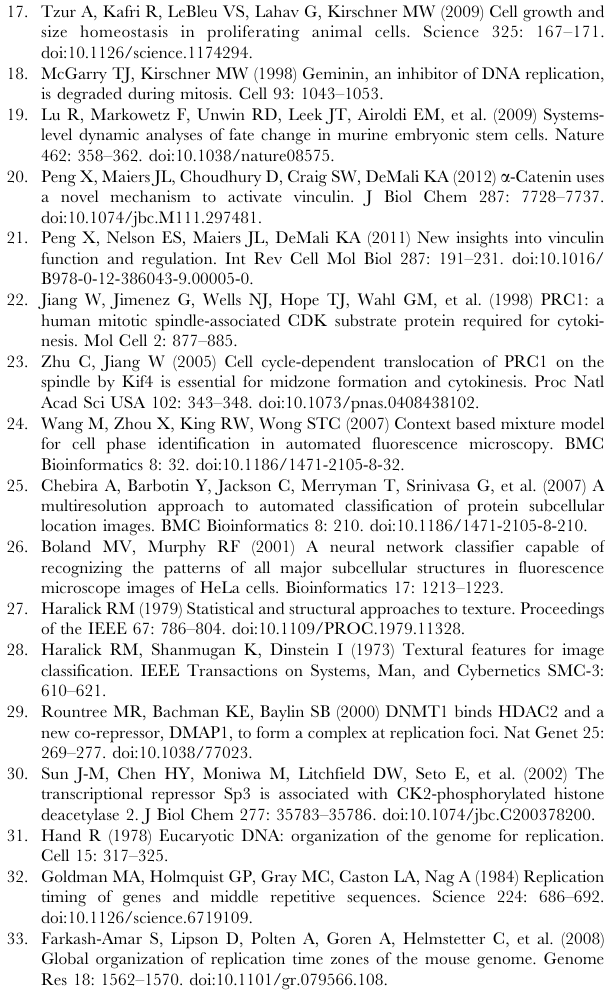
threshold distance of 0.3 was determined to exclude 95% of the experimental variation. (TIF) Figure 10 Normalization of partial tracks of single cells. This example illustrates how partial tracks of a single cell that divided 8 hours after the beginning of the movie to 2 daughter cells were used. The partial tracks were normalized to the average cell cycle (21 hours) and overlaid on the cell-cycle profile accordingly. (TIF) Table S1 The Supplementary table S1 includes the full dataset of protein profiles and scores. (XLSX) Material S1 The online Supplementary material includes additional information about the methods and results presented